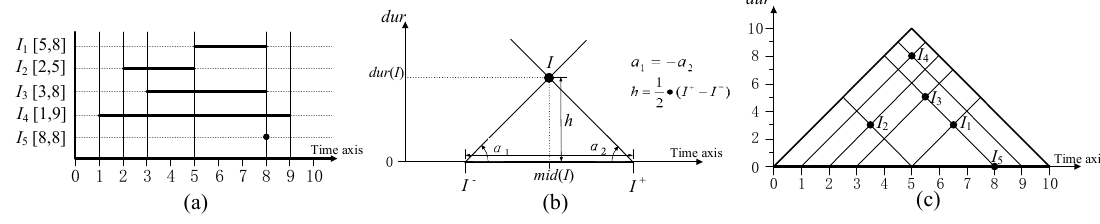
Figure 1. The transformation from the linear model to the triangular model (TM). ( a ) Time intervals in the linear model. ( b ) Projecting a time interval into a point in the TM. ( c ) Time intervals in ( a ) represented in the TM (adapted from [13]).